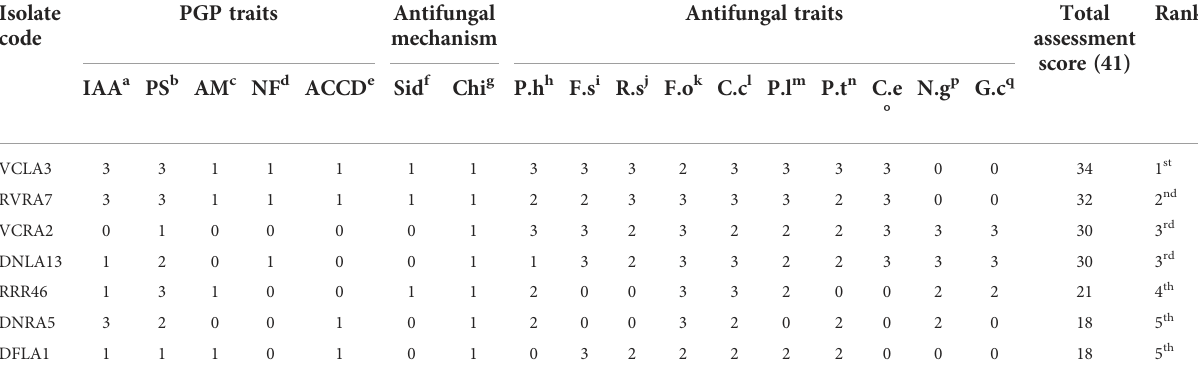
TABLE 4 Bonitur scale assessment and ranking of orchid associated endophytic actinobacteria based on PGP and antifungal traits. Isolate